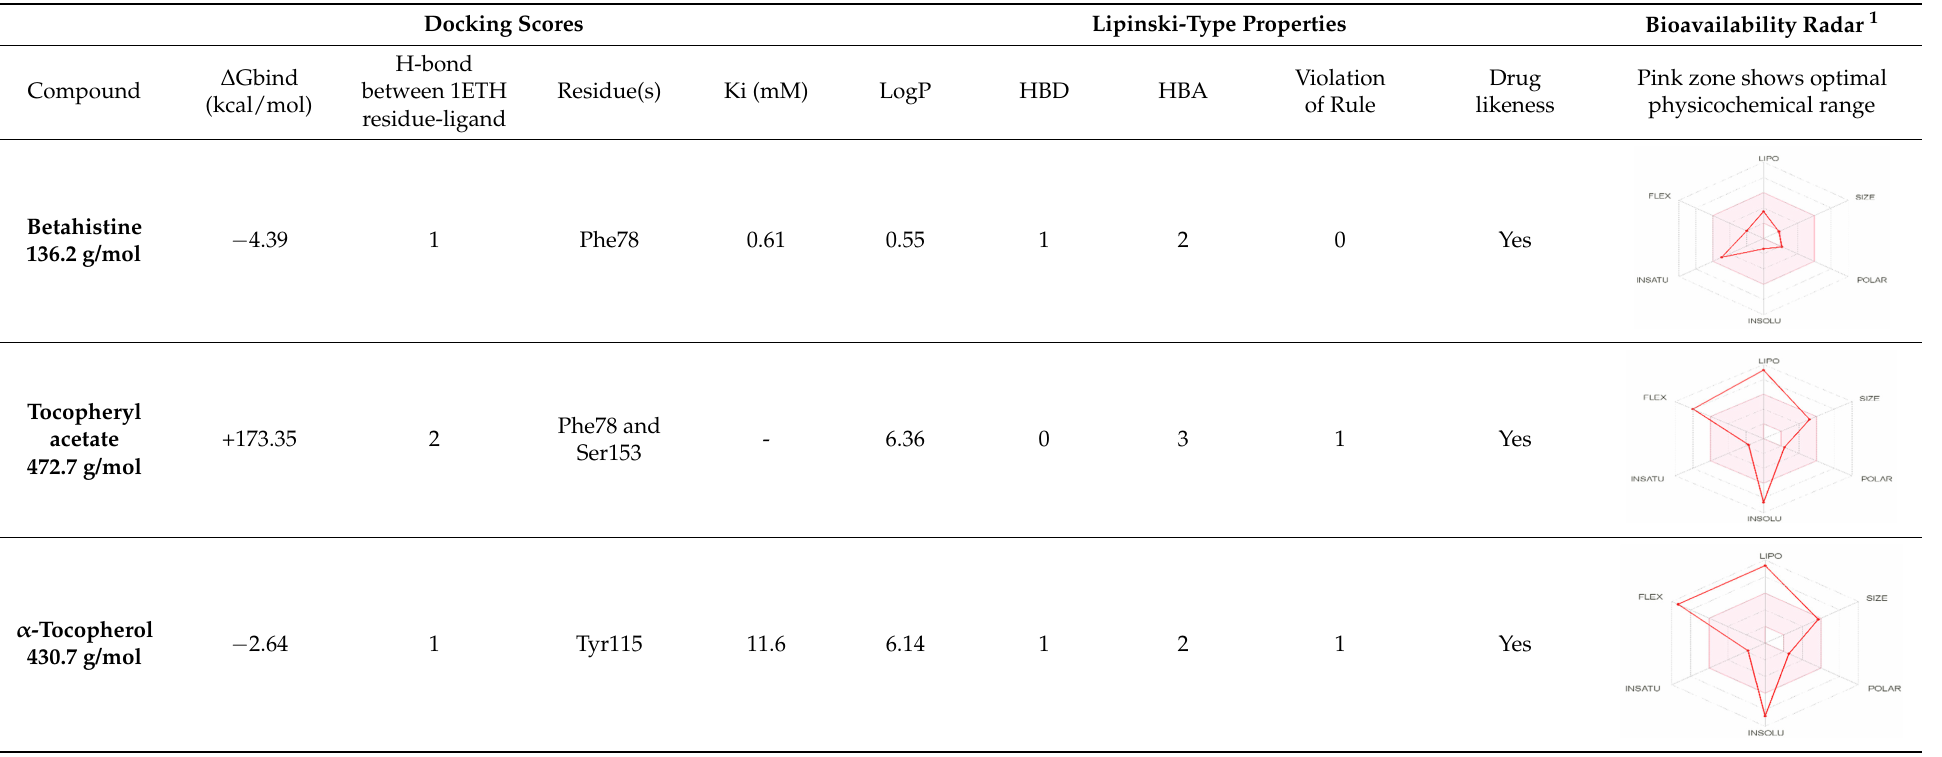
Table 4. Docking and bioavailability scores, and drug-likeness of the docked